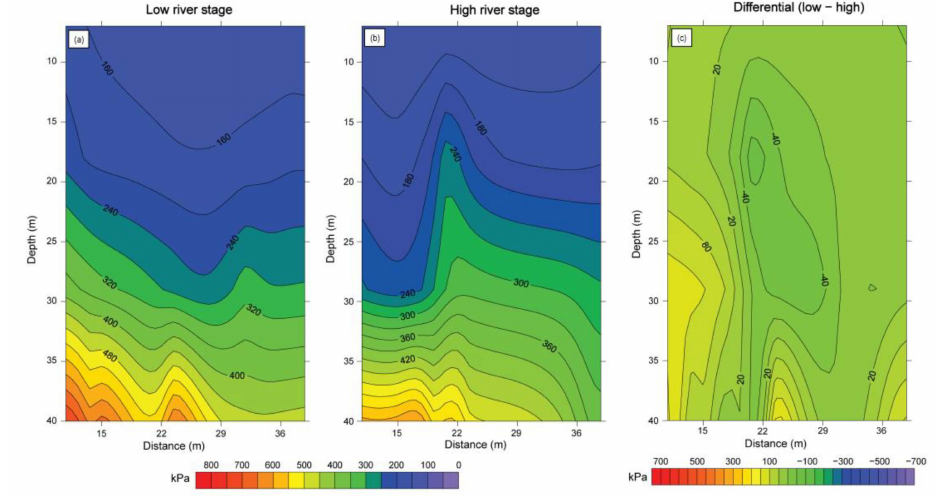
Figure 11. East side (355 m from levee toe) effective pressure profiles. Kriging-interpolated CMP interval velocities converted to effective pressure in kPa during ( a ) low and ( b ) high river stages, and the ( c ) differential effective pressure. Mean = 18 kPa and standard deviation = ± 50